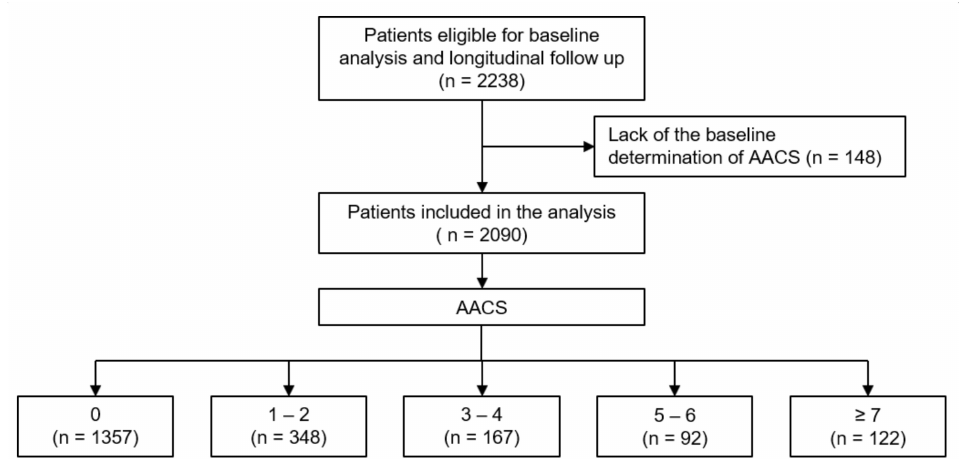
Figure 1. Flow diagram of the study participants. Abbreviations: AACS, abdominal aortic calcifica- tion